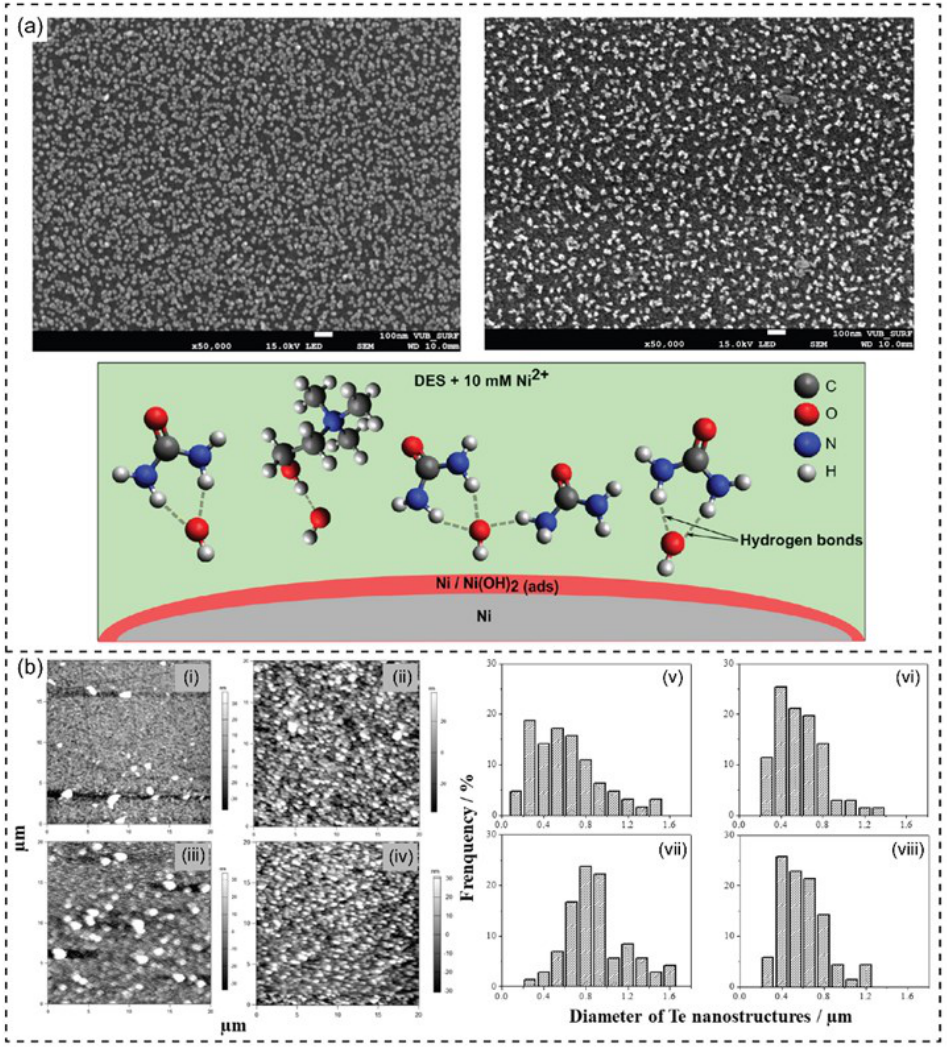
Figure 5. ( a ) FE-SEM images of the as-prepared nickel nanostructures by electrodeposition process from DES (ChCl-U) on glassy carbon ( above ) and schematic of the formation of hydrogen bonds between hydroxides and DES components-based ChCl-U ( below ). Reprinted with permission from ref. [140]. Copyright 2017 American Chemical Society. ( b ) AFM images of Te electrodeposits